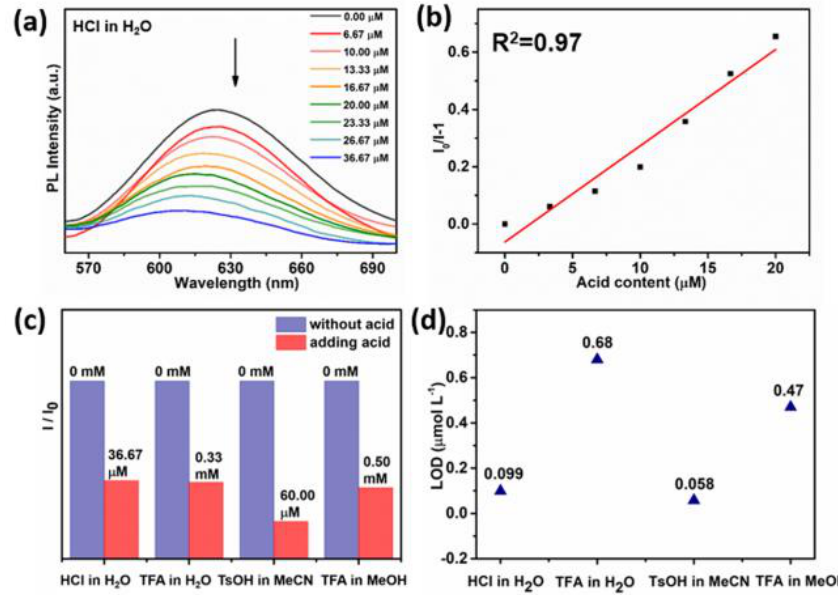
Figure 2. ( a ) Fluorescence spectra of TPBD-TA COF in HCl aqueous solution with different acid concentration ( λ ex = 365 nm), ( b ) the linear relationship between acid content and emission ratios, ( c ) emission ratio before and after adding acid, ( d ) the LOD values of detecting different acid in different solutions.